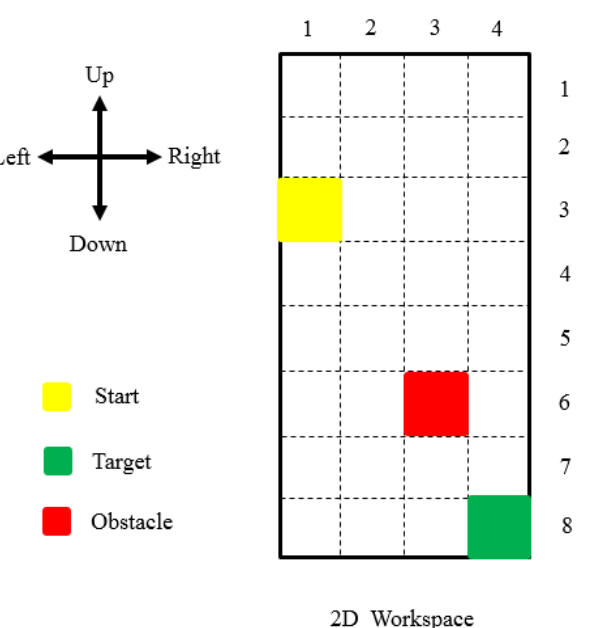
Figure 1. Scheme of the workspace: including start, target, obstacle from the top view, as well as, the actions.